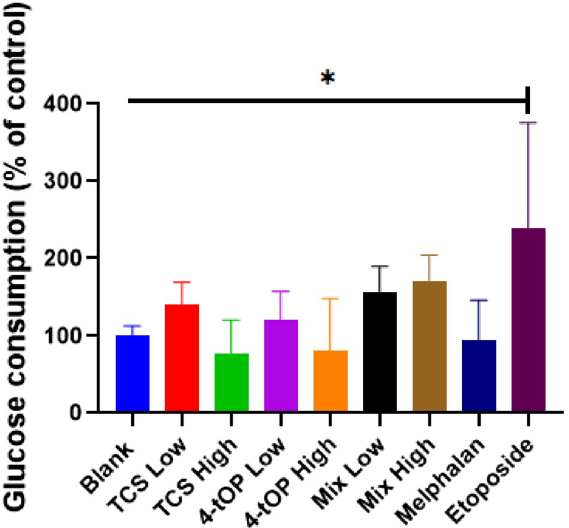
Figure 3. Effects of the test substances on cellular glucose uptake. p value* = 0.021, n = 5. TCS High/ Low, Triclosan High/Low concentration; 4-tOP High/Low, 4-tert-Octylphenol high/low concentration; Mix High/Low, TCS + 4-tOP high/low